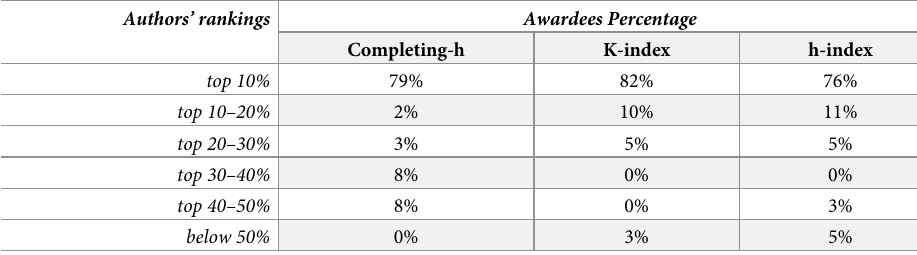
Table 10. Occurrence of award winners in ranked